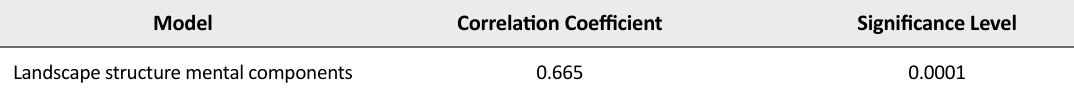
Table 3. The significance level of landscape structure and mental components